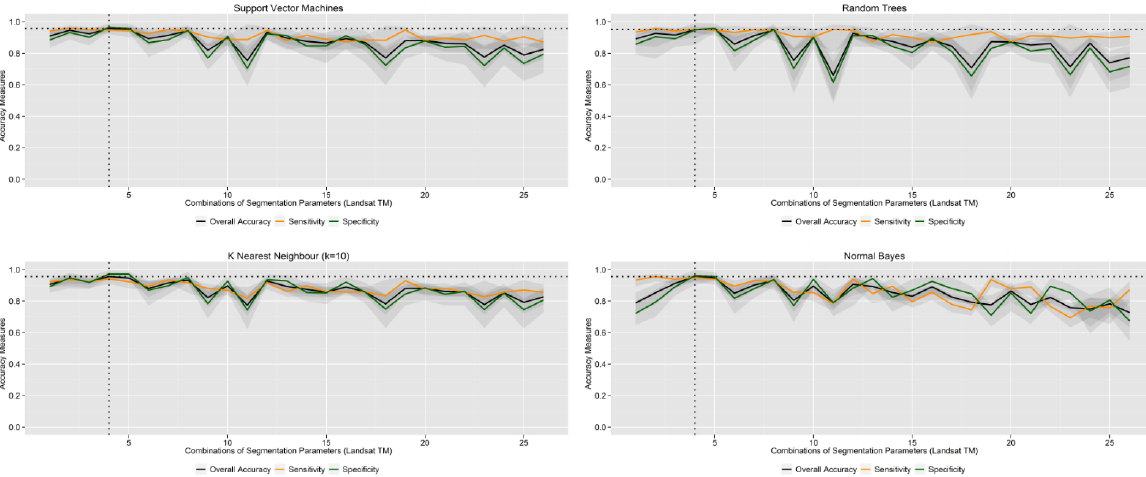
Figure 15. Influence of the segmentation inputs on the classification accuracy for TM with increasing average segment size from left to right. Mean and range of accuracy measures from the ten-fold cross-validation are shown for each